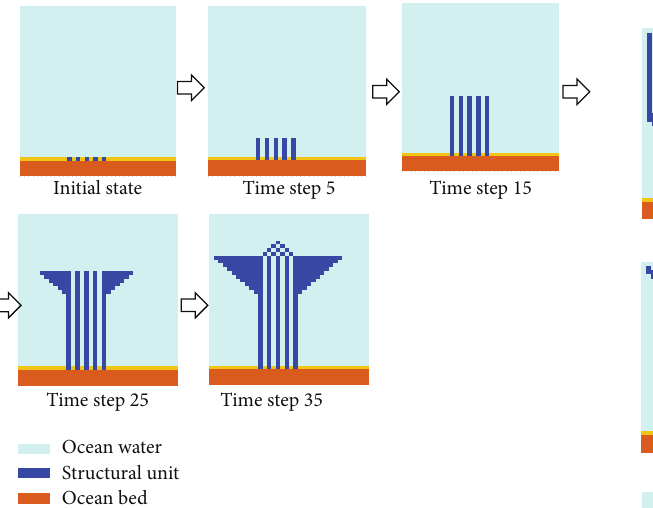
Figure 8: Calculation process of the shape in Figure 7. The struc- tural modules are piled up according to the algorithm of transition rule.